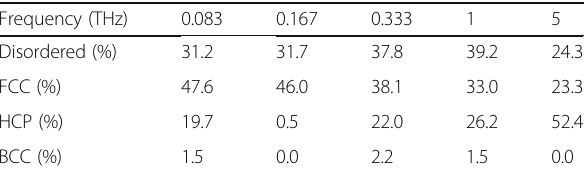
Table 4 Number fraction of atoms with different local crystalline orders in the products sintered under different vibration frequencies ( R = 5 a ) Frequency (THz) 0.083